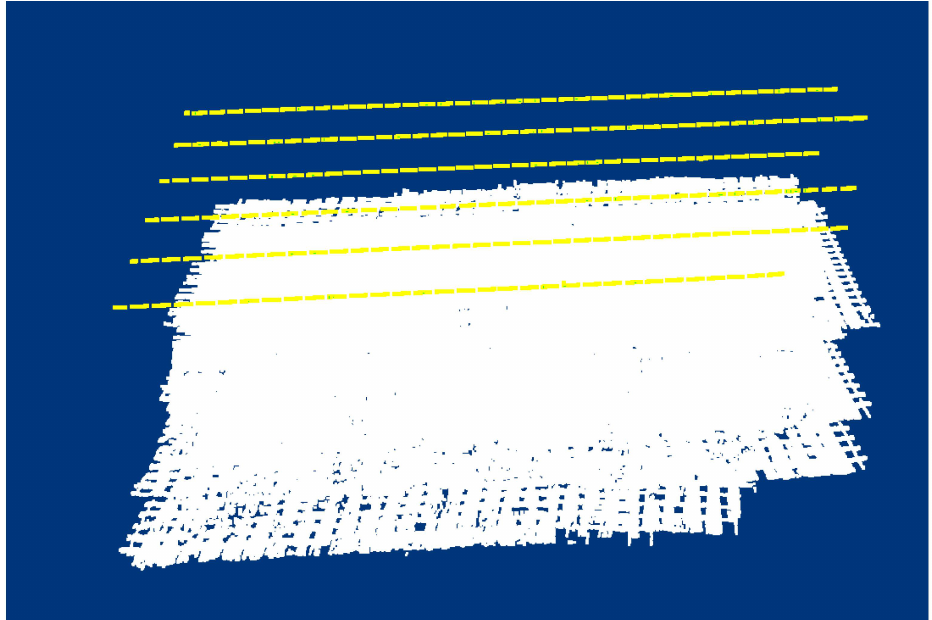
Figure 9. Sparse Point Cloud After the First